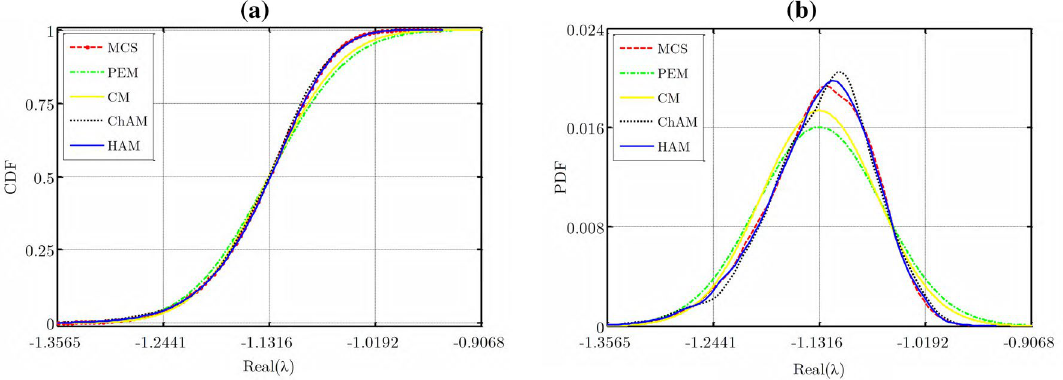
Fig. 6 a Cumulative distribution function, and b Probability distribution function of the real part of the mode#1 eigenvalue of the third gen- erator ( 𝜆